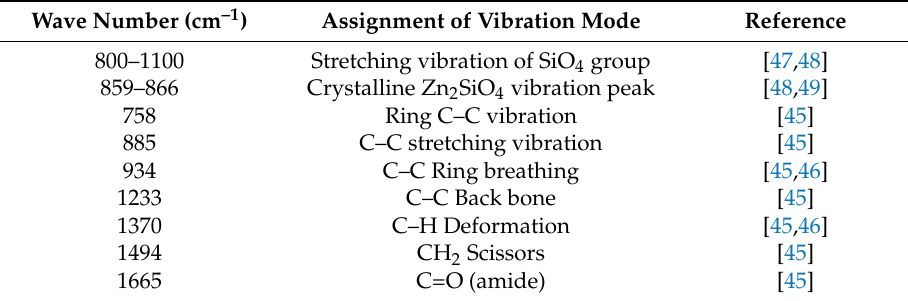
Table 1. Summary of the Raman absorption features and their